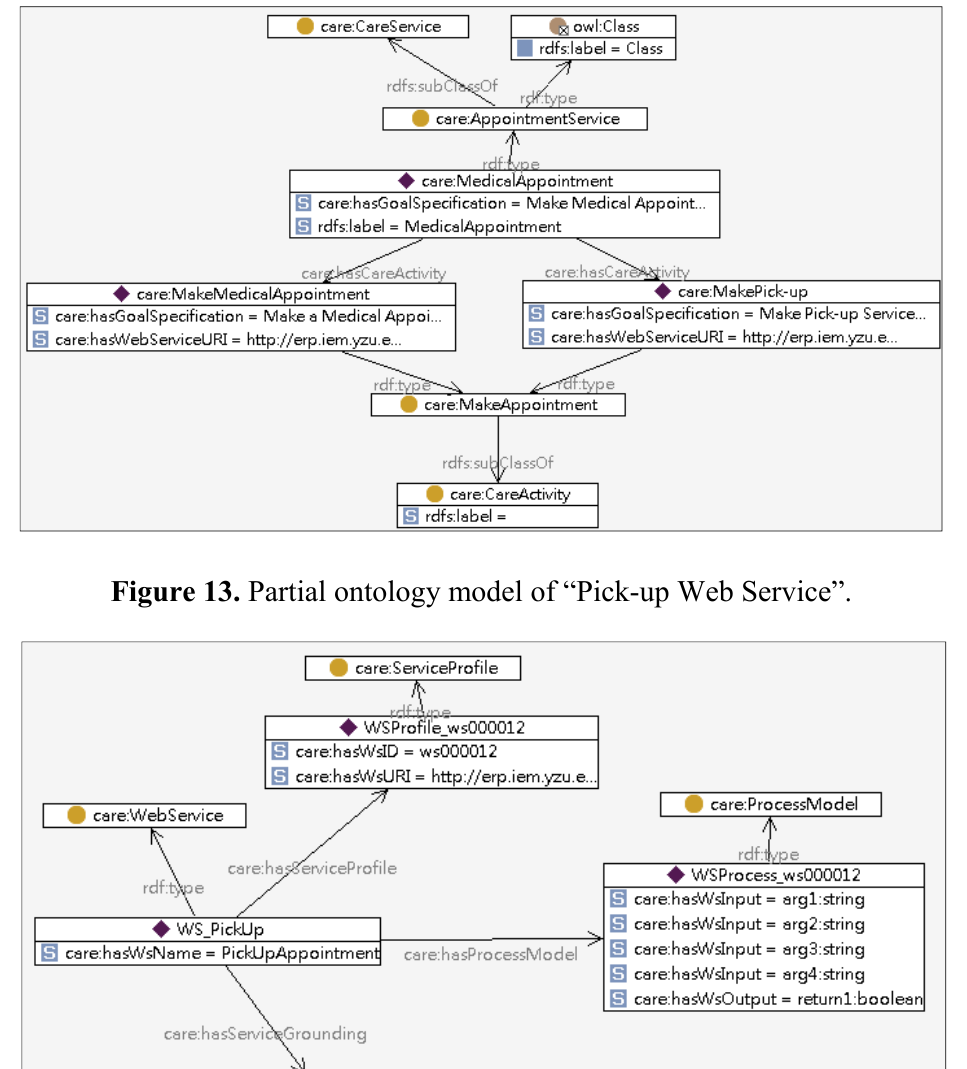
Figure 12. The partial ontology model of “Medical Appointment Service”.